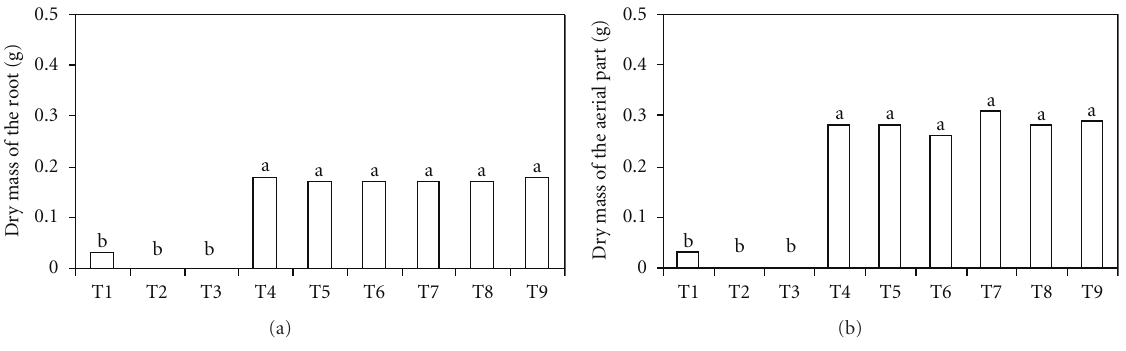
Figure 4: Dry root (a) and aerial part (b) mass of Ormosia arborea seedlings submitted to di ff erent dormancy breaking treatments. T 1 : control; T 2 : immersion in 100 ◦ C water; T 3 : immersion in boiling water followed by 24 h of soaking; T 4 and T 5 : scarification with number 100 and number 50 sandpaper, respectively; T 6 , T 7 , T 8 , and T 9 : immersion in sulfuric acid for 1 hour, 50min, 45min, and 30 min,